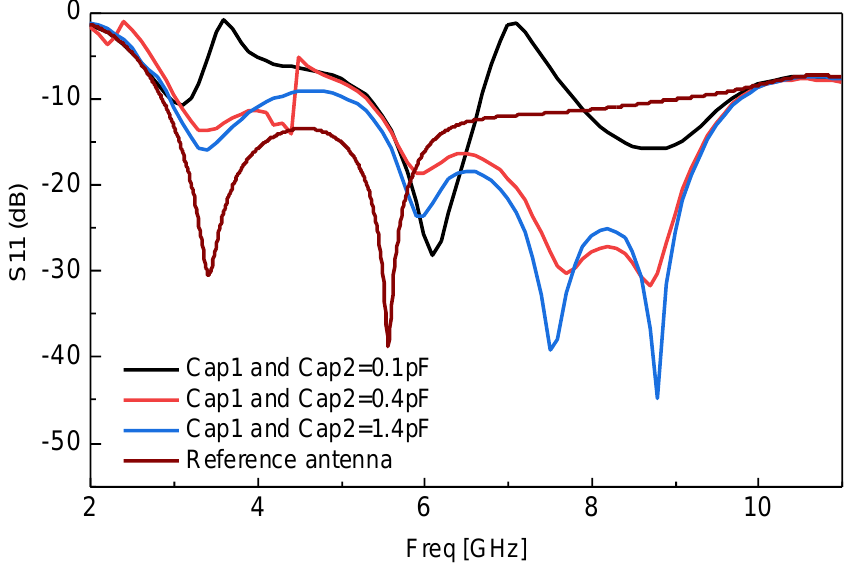
Figure 4. Switching between UWB and dual notched UWB by simultaneously changing Cap1 and Cap2 of the proposed resonator.